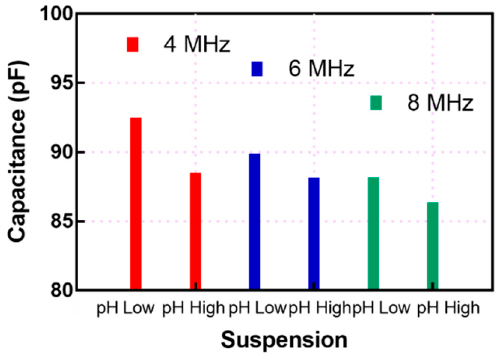
Figure 5. Measured capacitance for two different concrete solutions at room temperature.